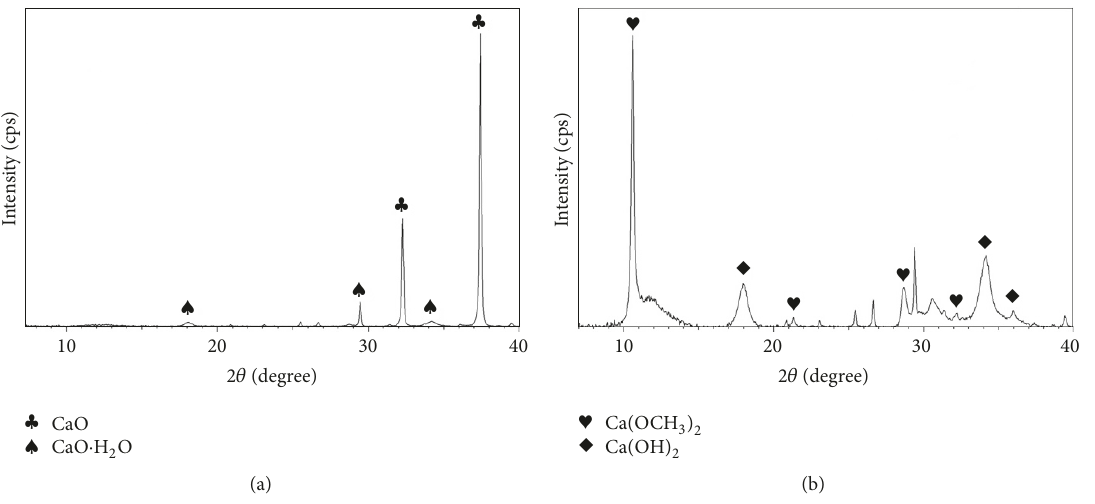
Figure 2: XRD patterns. (a) Calcined quick lime powder. (b) Ca(OCH 3 ) 2 .